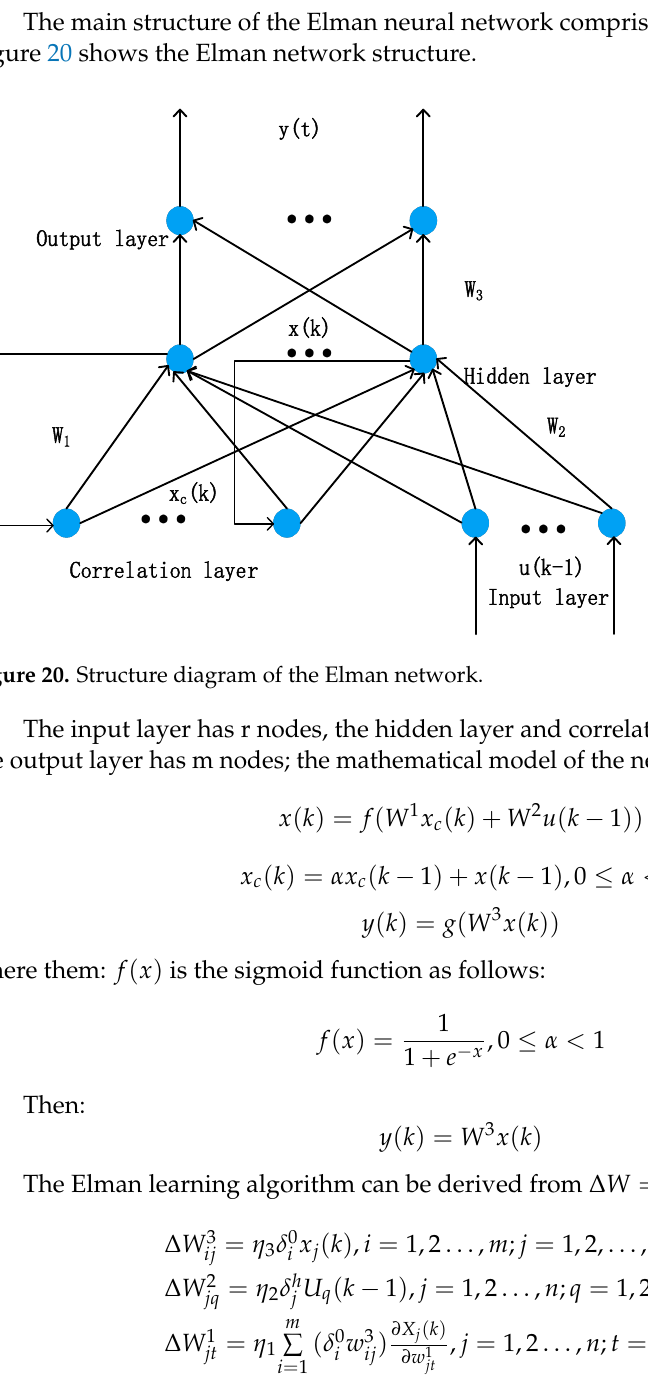
Figure 19. E rror between the actual and predicted values.